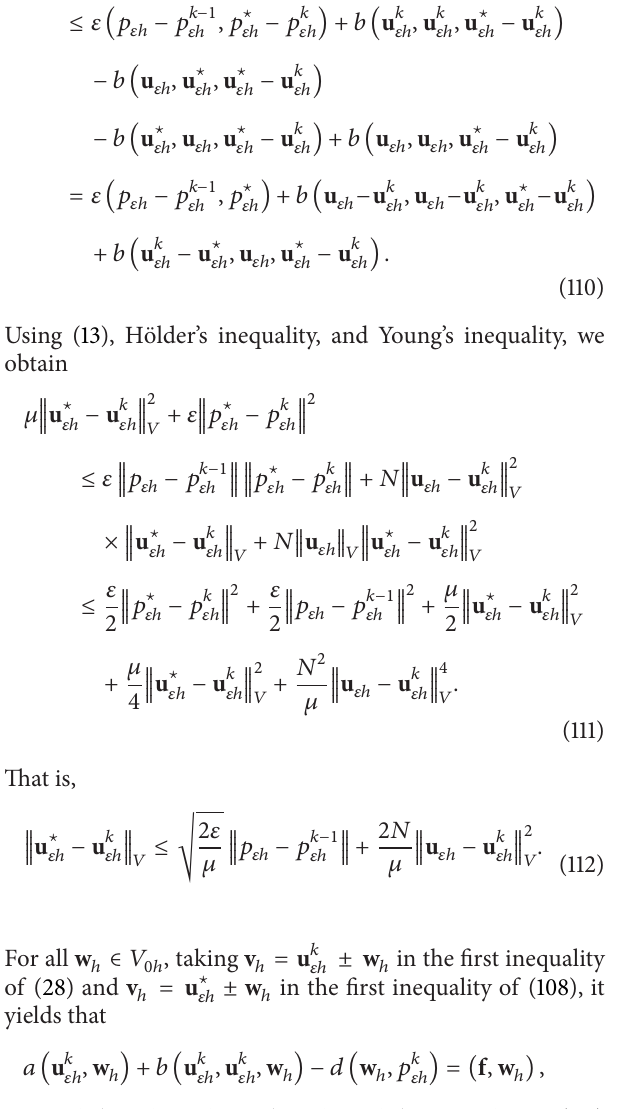
Figure 1: Domain Ω